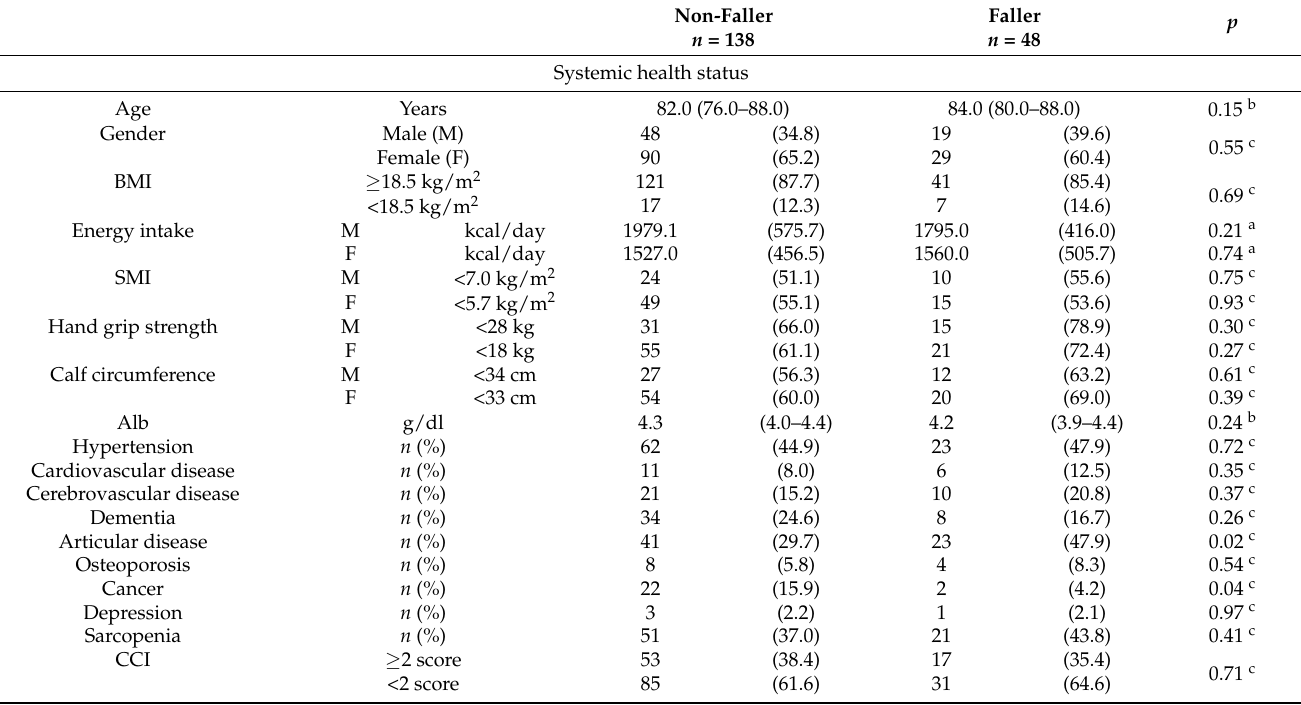
Table 1. Basic characteristics of study